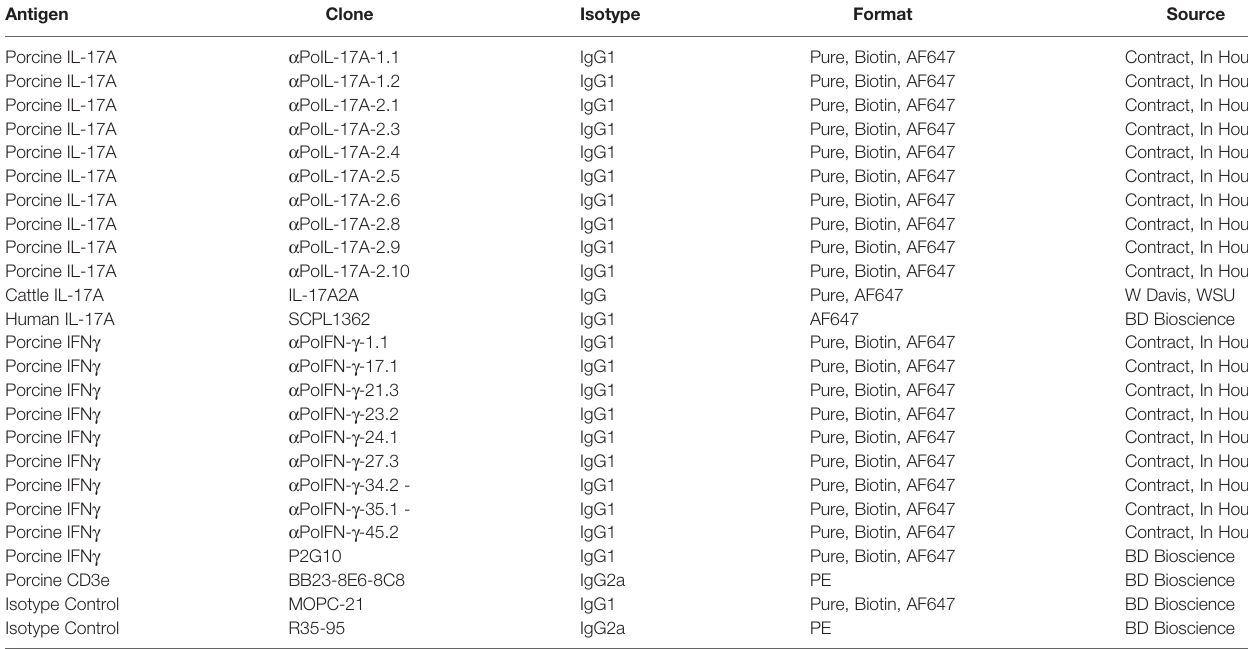
TABLE 1 | Antibodies used in this